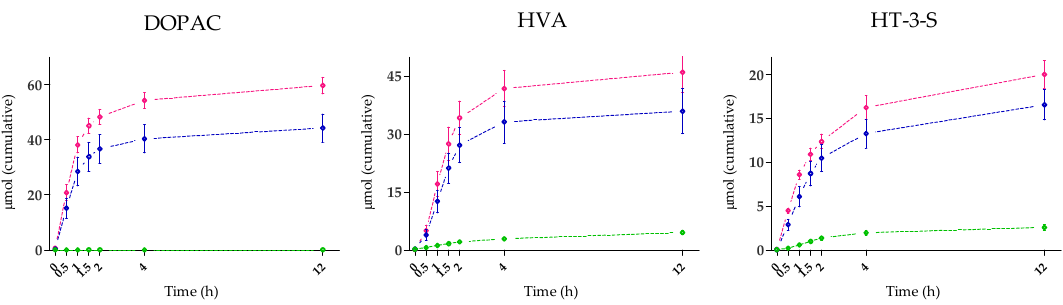
Figure 2. Mean urinary excretion of main HT metabolites quantified before (0 h) and after intake of the investigational products. Blue lines: IP-1 ( n = 12), pink lines: IP-2 ( n = 13), green lines: EVOO ( n = 12). Bars: SEM.